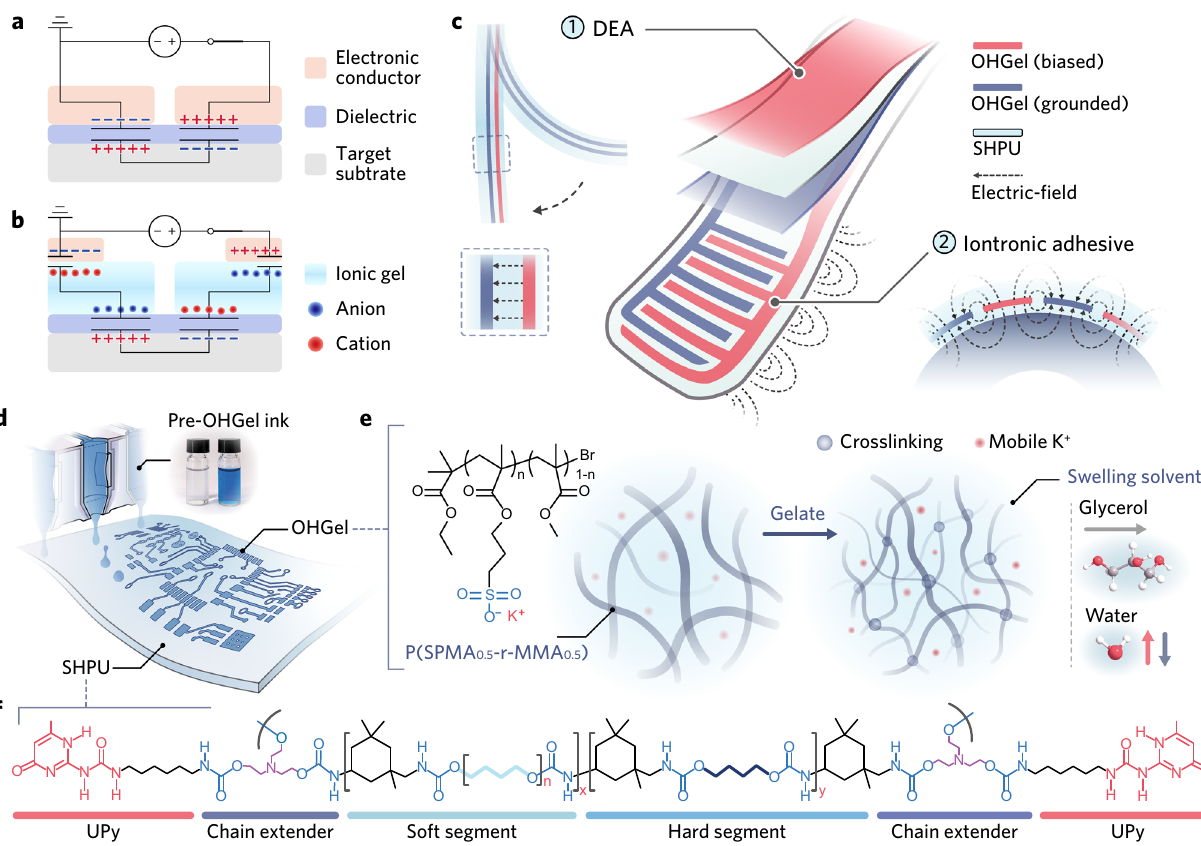
Fig. 1 | Electrostatic adhesion mechanisms and supramolecular OHGel-SHPU system.a , b Schematicillustrationsand equivalentcircuitsof( a )electroadhesives and ( b ) iontronic adhesives when adhering on a conductive substrate. c Conceptualillustrationsofasoftiontronicadhesiveunit,andthemechanismsof DEA and electrostatic adhesion. The exact device structural design is available in Fig. 4a. d Illustrative inkjet printing process of OHGel electrodes on a SHPU